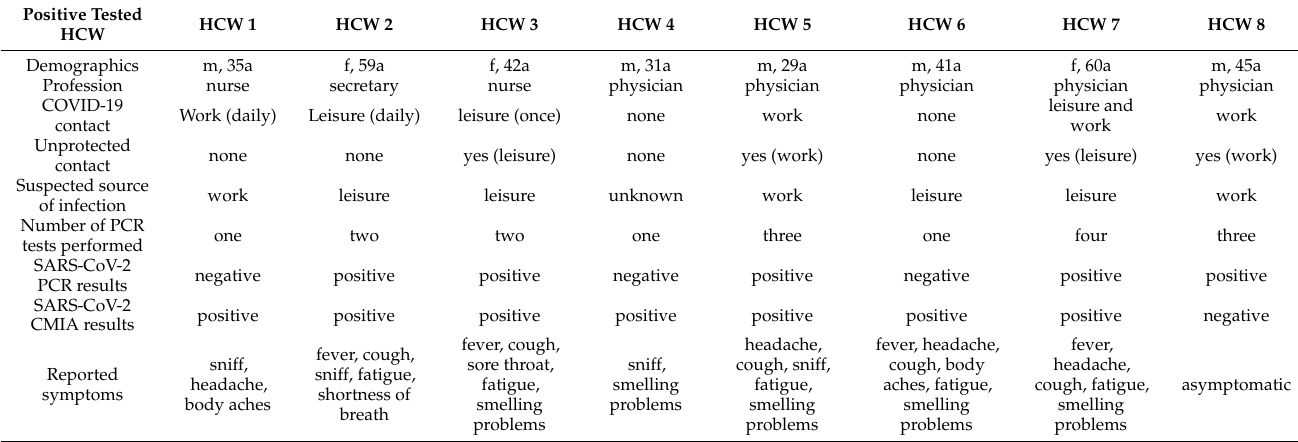
Figure 1. highlights all HCW recruited in our study. Triangles highlight unprotected contact, the colour blue highlights a positive test result and a blue triangle demonstrates a positive tested HCW with history for unprotected contact. COVID-19, Coronavirus Disease 19. Table 2. All positive tested HCW at our center by neutralization test. m, male; f, female; COVID-19, Coronavirus Disease 19; HCWs, Health Care Workers; SARS-CoV-2, severe acute respiratory syndrome coronavirus; PCR, polymerase chain reaction; CMIA, chemiluminescent microparticle